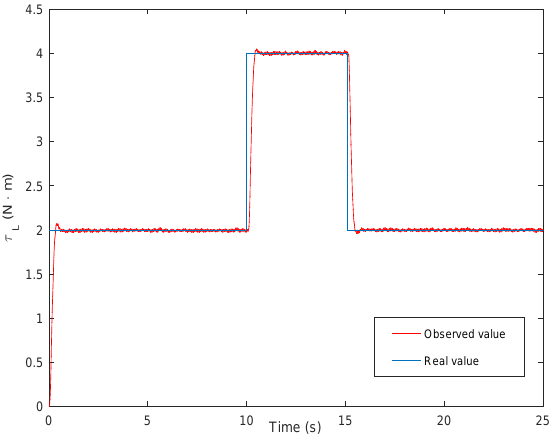
Figure 12. Experimental curve of load disturbance tracking based on the